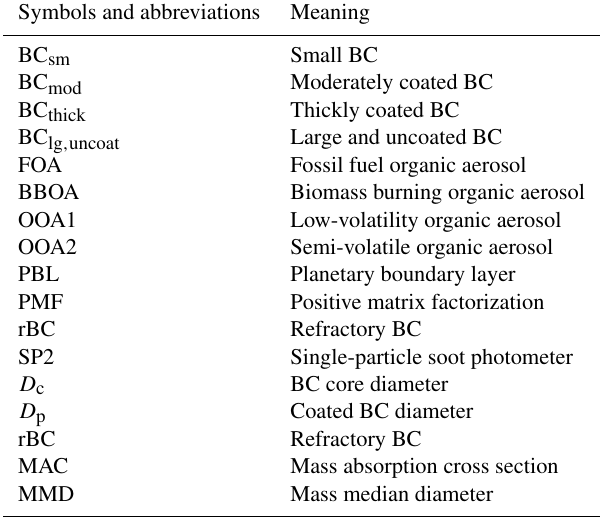
Table A1. Symbols and